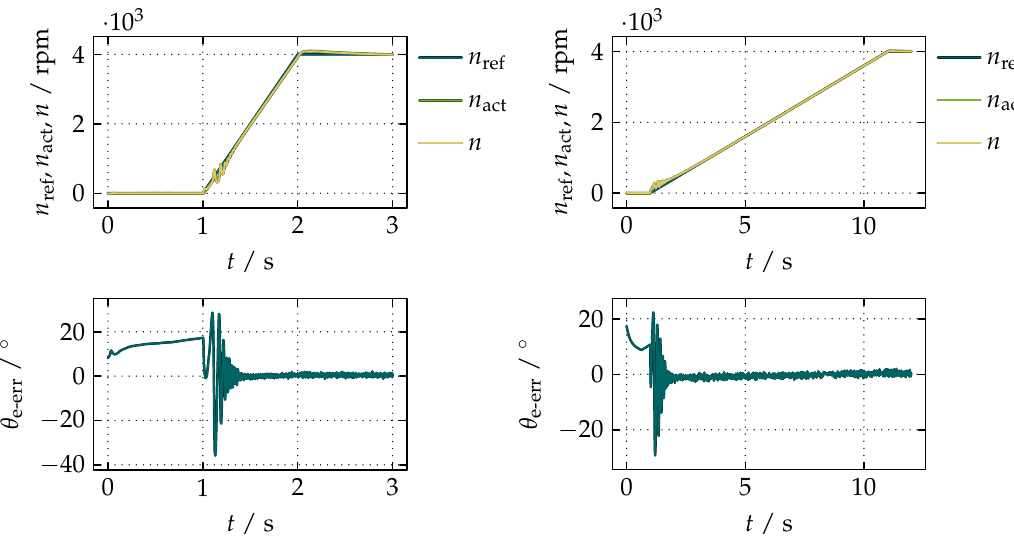
Figure 15. Acceleration of the unloaded motor from 0 rpm to 4000 rpm within 1 s ( left ) and 10 s ( right